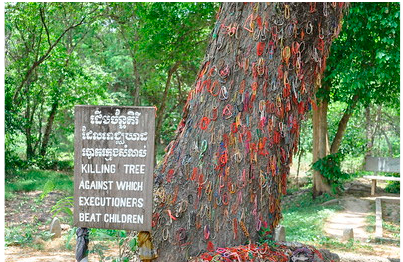
Figure 1. Killing Tree against which babies were executed. Resource from: https://protect-au. mimecast.com/s/aXxcCGv0kQtWBvg6I0hZc8?domain=search.creativecommons.org (accessed on 25 March